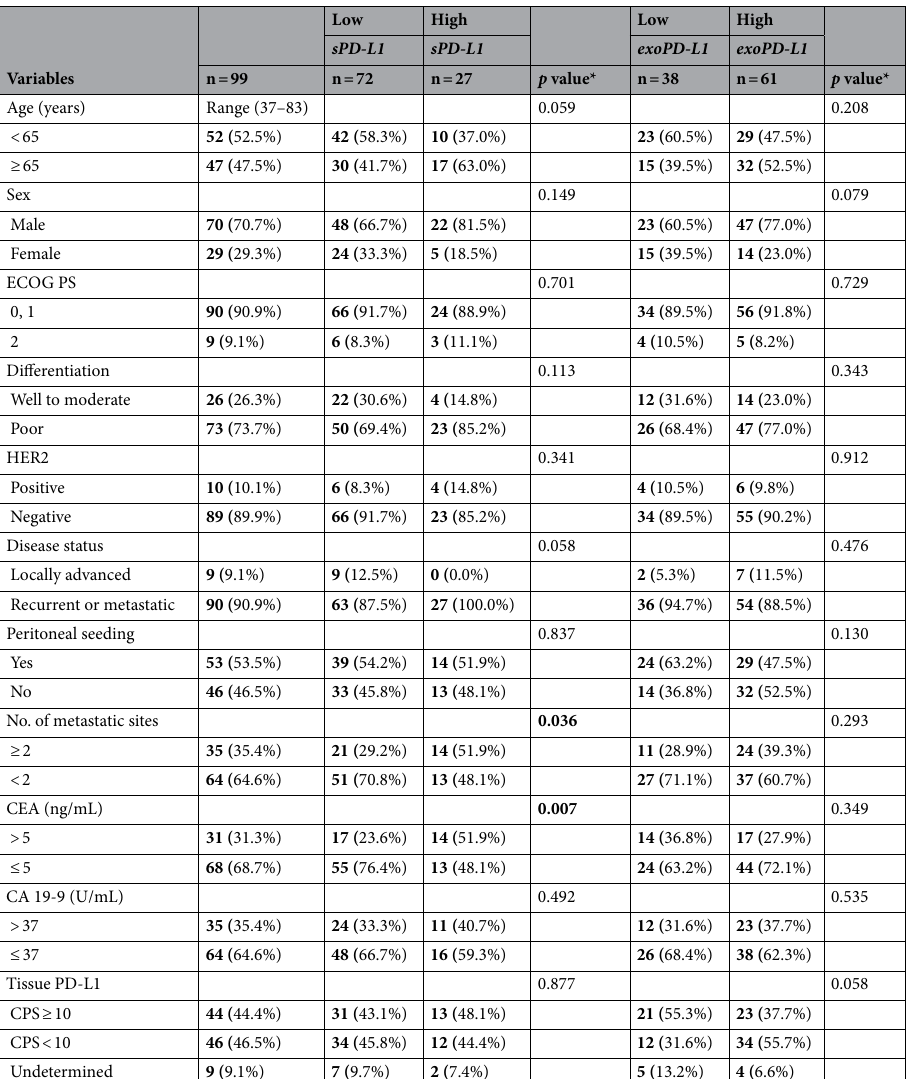
Table 1. Baseline characteristics. Data are n (%). * p value from Chi-square test or Fisher’s exact test for categorical variables. HER2 human epidermal growth factor receptor 2, CEA carcinoembryonic